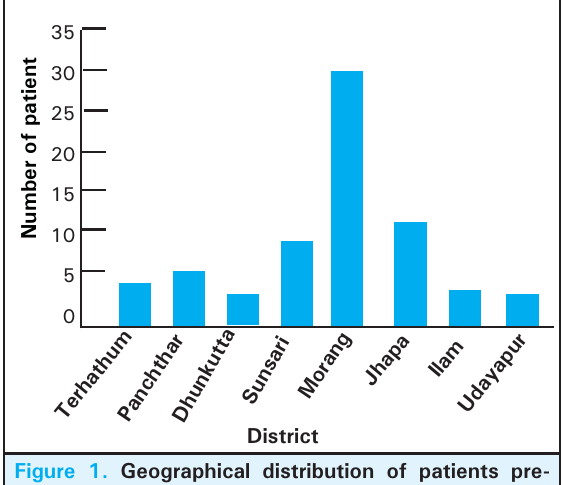
Figure 1. Geographical distribution of patients pre- senting with mushroom poisoining.